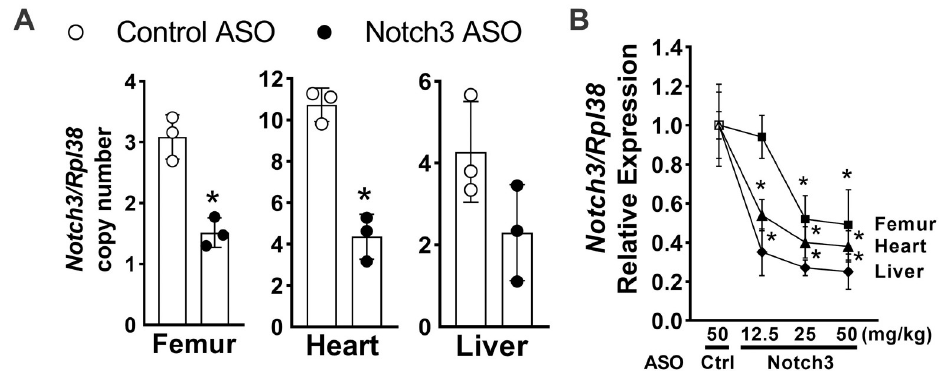
Fig 3. Effect of control or Notch3 ASOs administered subcutaneously to C57BL/6 wild type mice on Notch3 mRNA. In panel A, Notch3 (closed circles) or control (open circles) ASOs were administered at 50 mg/kg and Notch3 copy number corrected for Rpl38 was determined 96 h later in femur, heart and liver. In panel B, Notch3 ASOs were administered at the indicated doses and compared to control ASO administered at 50 mg/kg and Notch3 copy number corrected for Rpl38 was determined 72 h later in femur, heart, liver and shown as relative expression normalized to a control value of 1. In panel A, individual values are shown, and bars and ranges represent means ± SD. In panel B, values represent means ± SD; n = 3. Data are biological replicates. � Significantly different between Notch3 and control ASO, p < 0.05.